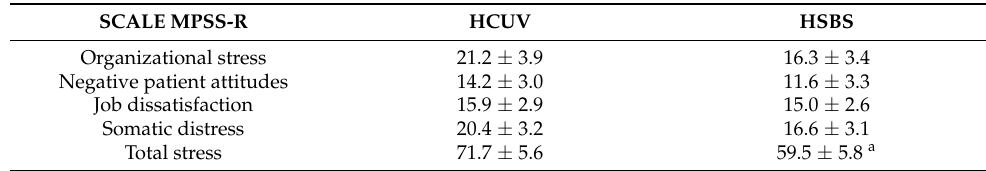
a Significant difference ( p < 0.05) with respect to